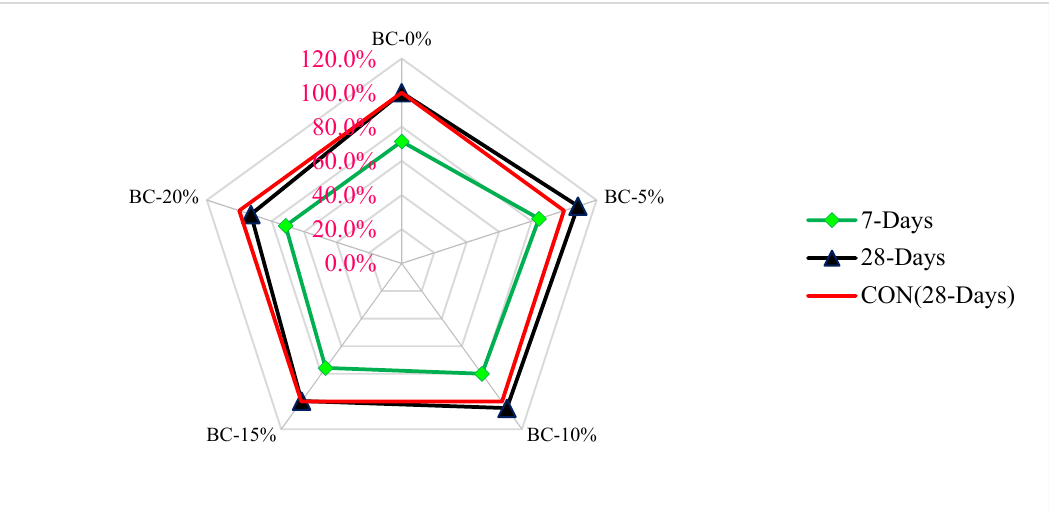
Figure 8. Relative analysis of split tensile strength (data source [58]).